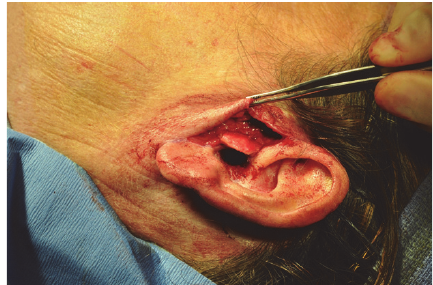
Figure 3: Intraoperative photograph showing the cartilage graft placement into the pretragal pocket.